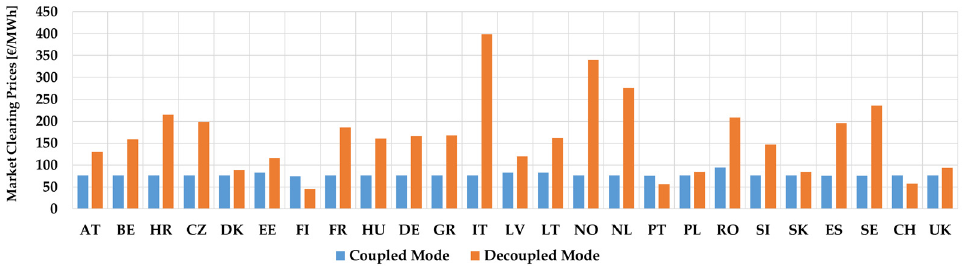
Figure 8. Market clearing prices attained for each participating control area.